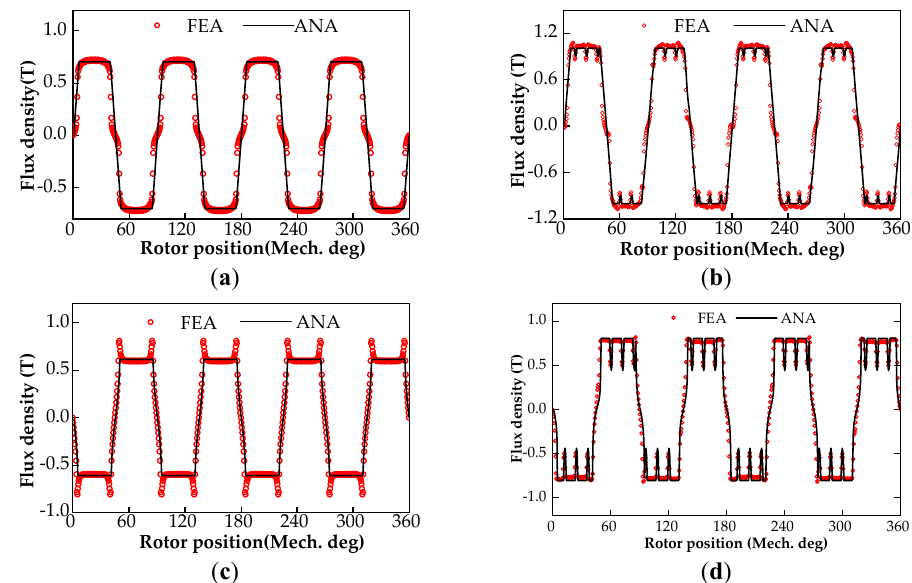
Figure 6. No-load air-gap flux density distribution of the four typical PMECCs: ( a ) Model − A; ( b ) Model − B; ( c ) Model − C; ( d ) Model − D.